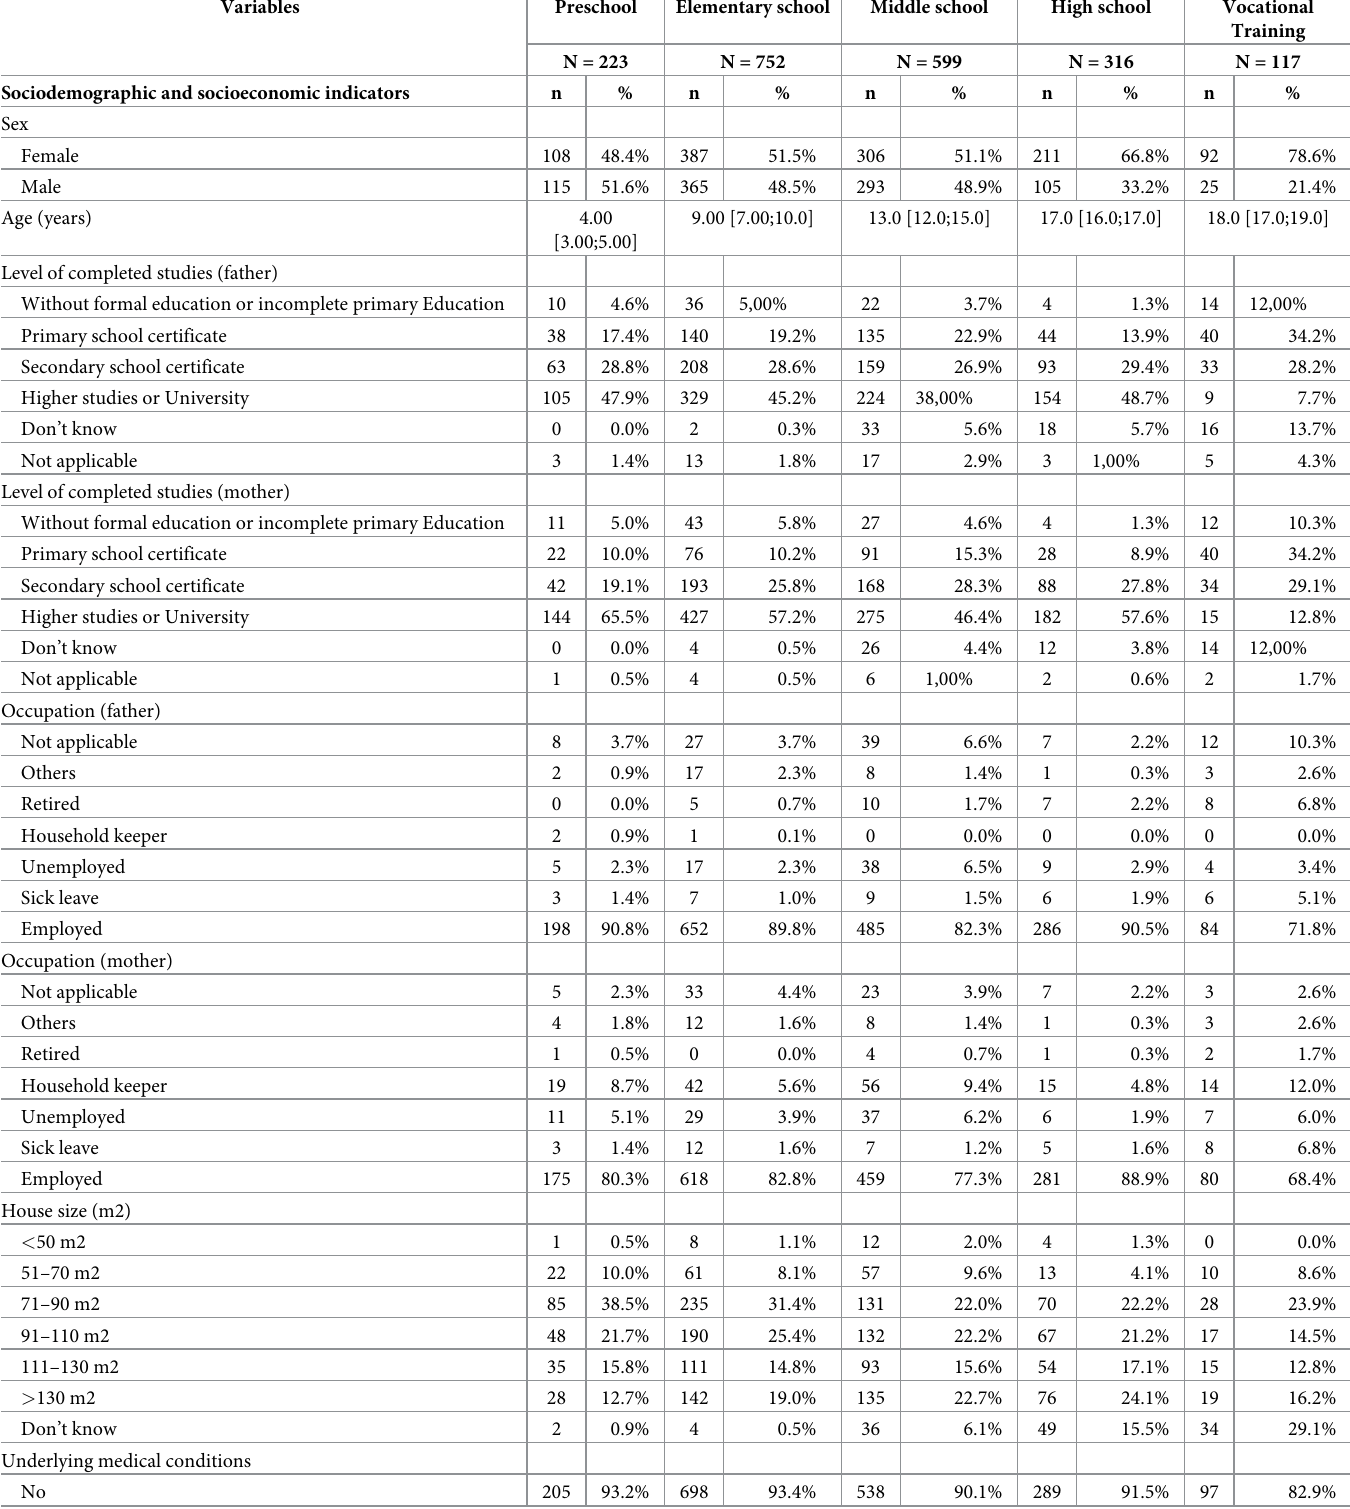
Table 2. General characteristics of the students participating in the sentinel school project, Catalonia, Spain. February-March 2021. Variables